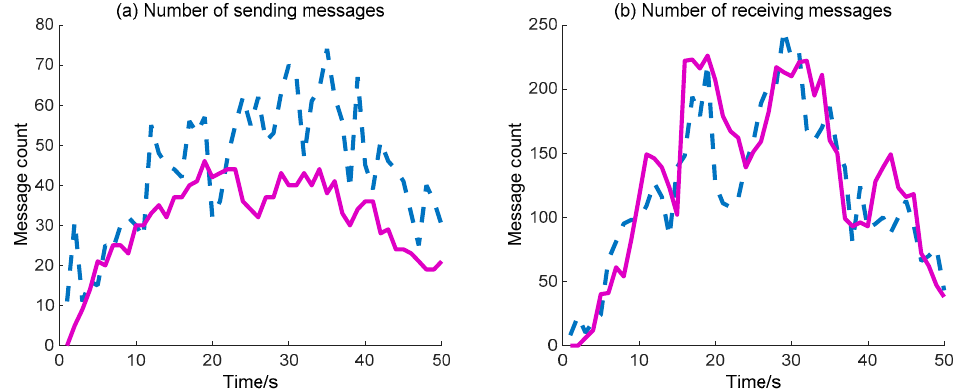
Figure 13. The WC performance of the sending and receiving messages numbers: ( a ) Number of sending messages. ( b ) Number of receiving messages. ( — : BDIIM; -- : DIDM). Table 7. The numbers of sending and receiving messages nodes in the WC.